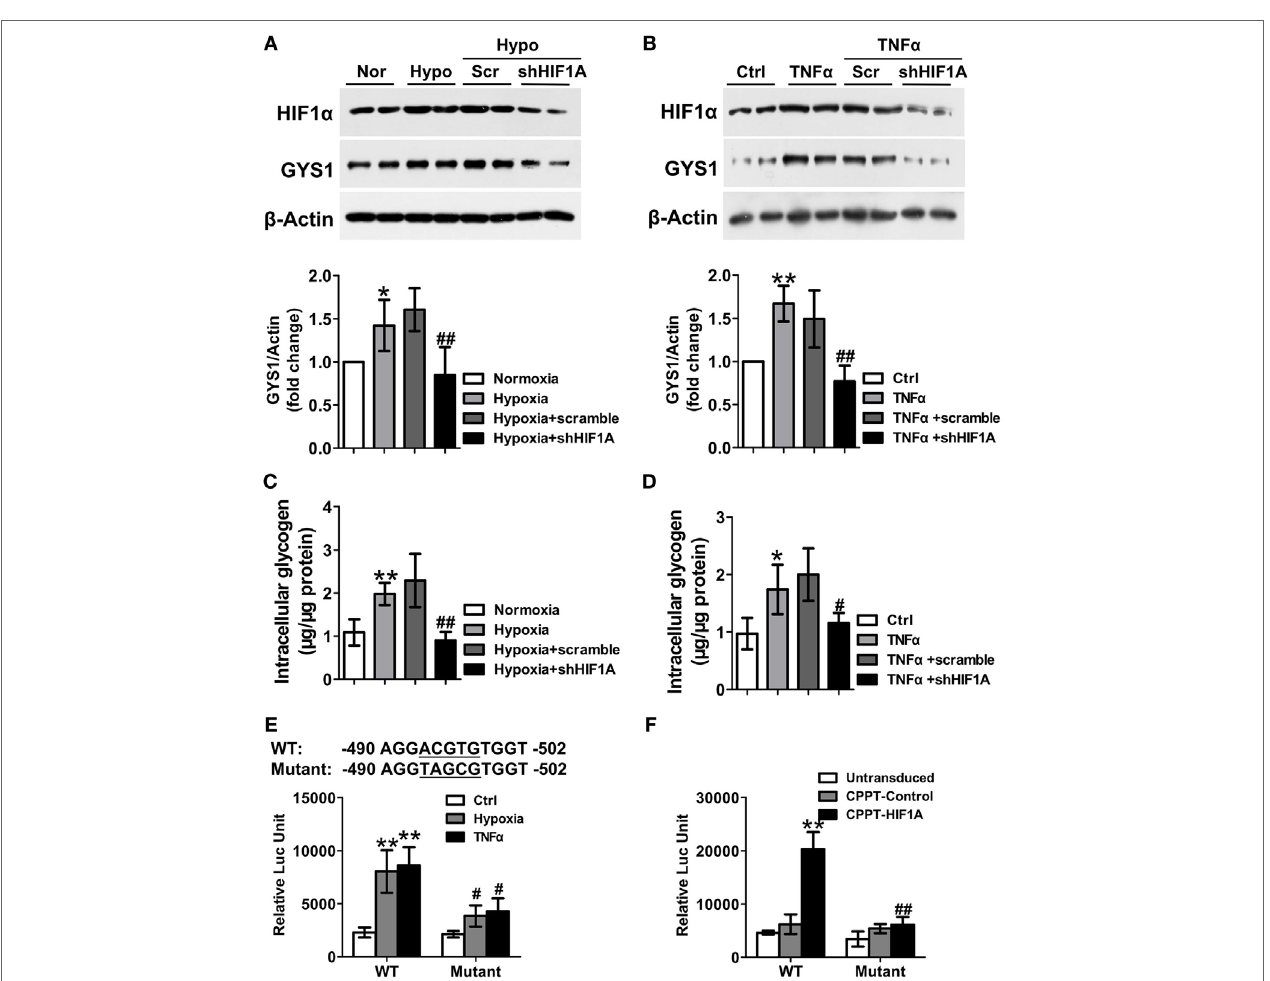
FigUre 5 | Hypoxia-inducible factor (HIF)-1 α mediates the increased expression of glycogen synthase 1 (GYS1) in rheumatoid arthritis (RA) fibroblast-like synoviocytes (FLSs). (a–D) Effect of HIF-1 α depletion on GYS1 expression and intracellular glycogen levels in RA FLSs. RA FLSs transfected with scramble or HIF1A shRNA were exposed to normoxic (21% O 2 ) or hypoxic conditions (1% O 2 ) (a,c) or stimulated with TNF- α (10 ng/ml) (B,D) for 24 h. The data are presented as the mean ± SEM of four independent experiments. (e) MH7A cells were transfected with wild-type (WT) or mutant GYS1 reporter plasmids. Approximately 48 h after transfection, the cells were exposed to 1% O 2 or TNF- α (10 ng/ml) for 24 h, and luciferase activity was measured. (F) MH7A cells were co-transfected with GYS1 reporter and HIF-1 α expression plasmid, and luciferase activity was measured 48 h after transfection. The data are presented as the mean ± SD of three independent experiments. * P < 0.05, ** P < 0.01 vs. healthy control or normoxia or control or CPPT-Control; # P < 0.05, ## P < 0.01 vs. osteoarthritis or hypoxia + scramble or TNF- α + scramble or WT.